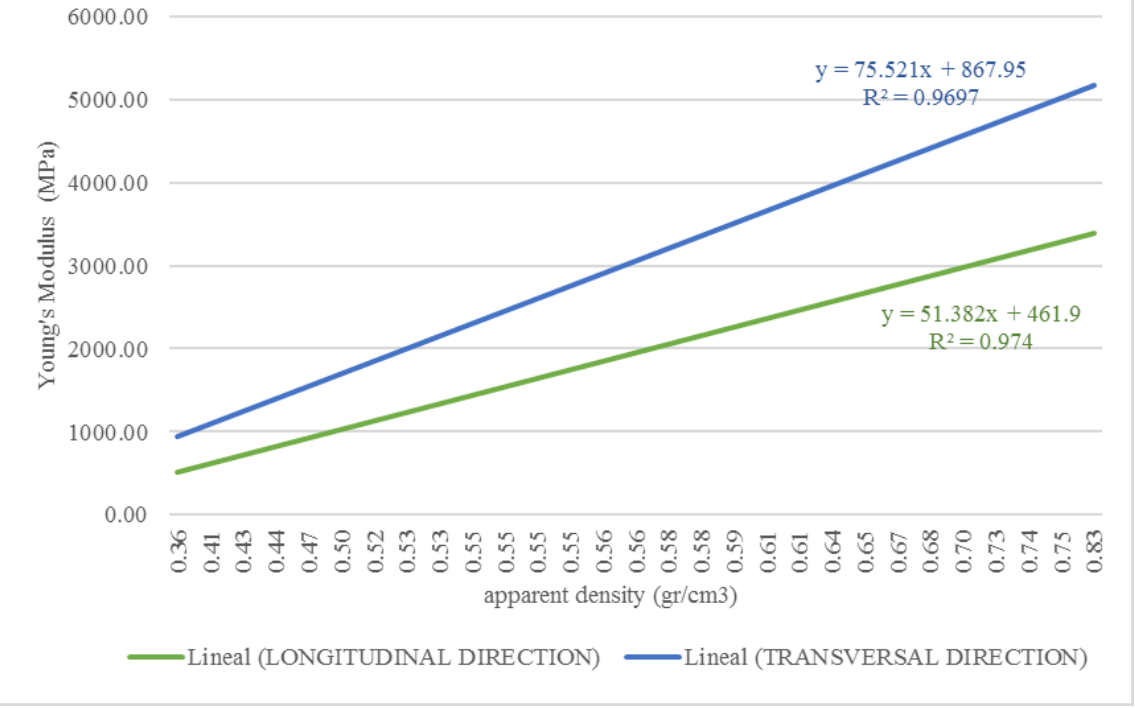
Figure 6. Relationship between apparent density and Young’s modulus for trabecular tissue affected with OI in the longitudinal and transversal direction.